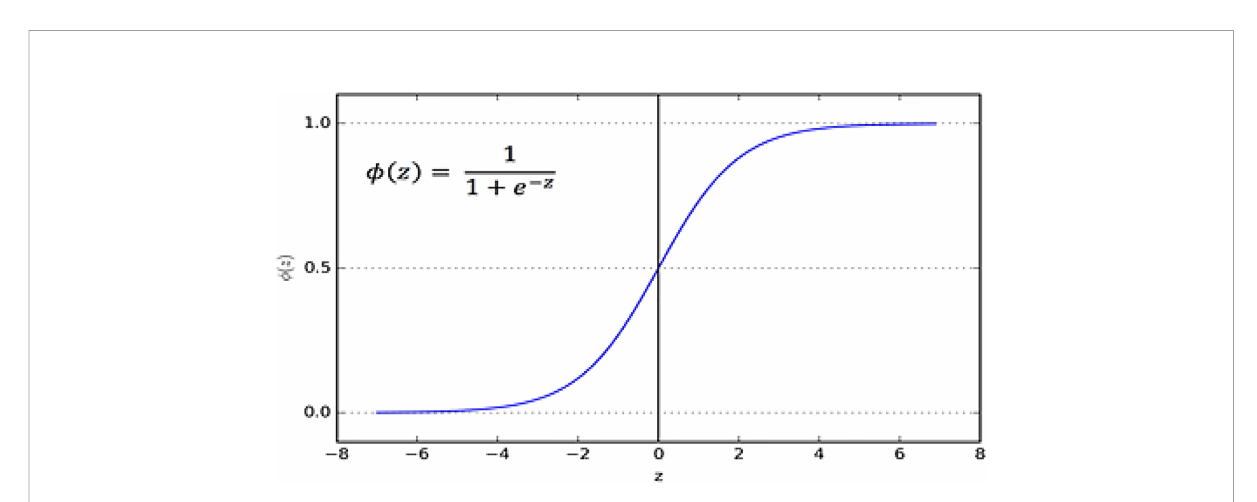
FIGURE 8 Sigmoid function.